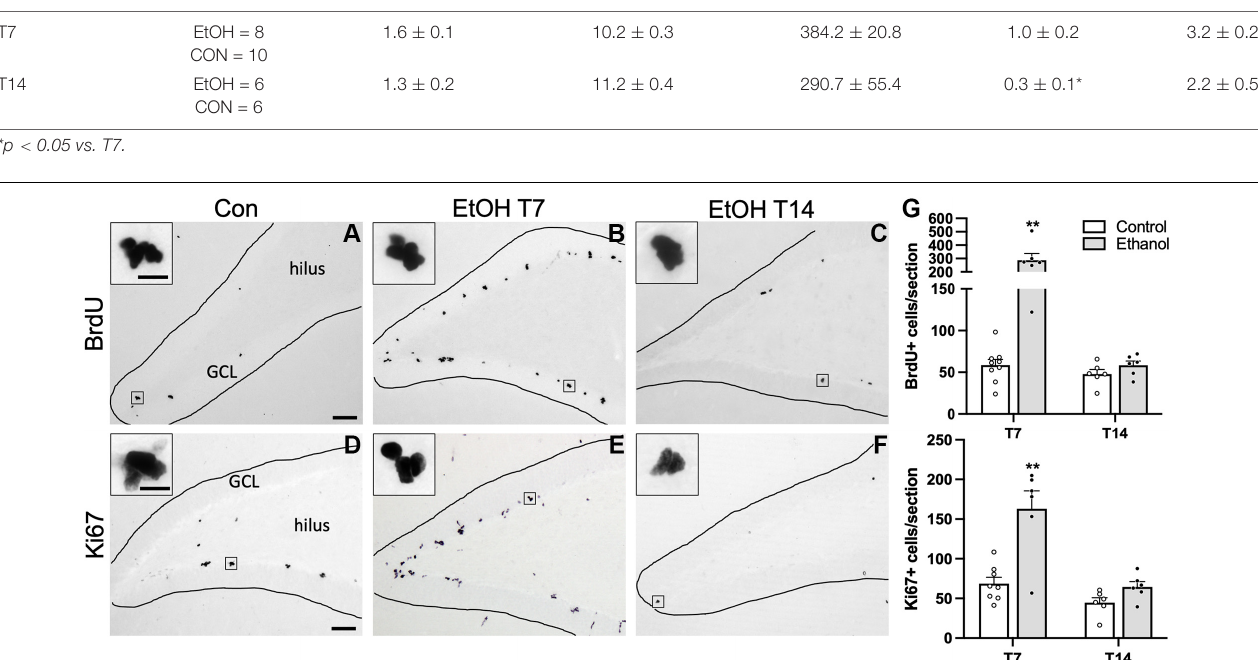
FIGURE 2 | Cellular proliferation markers are increased following 7 or 14 days of abstinence in ethanol-treated rats. Representative images are shown for BrdU (A–C) and Ki67 (D–F) immunoreactivity in control [ (A) BrdU: n = 9; (D) Ki67: n = 8], T7 ethanol-exposed [ (B) BrdU: n = 6; (E) Ki67: n = 6), and T14 ethanol-exposed rats [ (C) BrdU: n = 6; (F) Ki67: n = 6). (G) BrdU+ cells were counted throughout the SGZ and were increased significantly in the T7 ethanol-treated rats compared to controls and T14 ethanol-exposed rats. BrdU expression was confirmed with immunohistochemistry of the endogenous proliferation marker Ki67. As observed